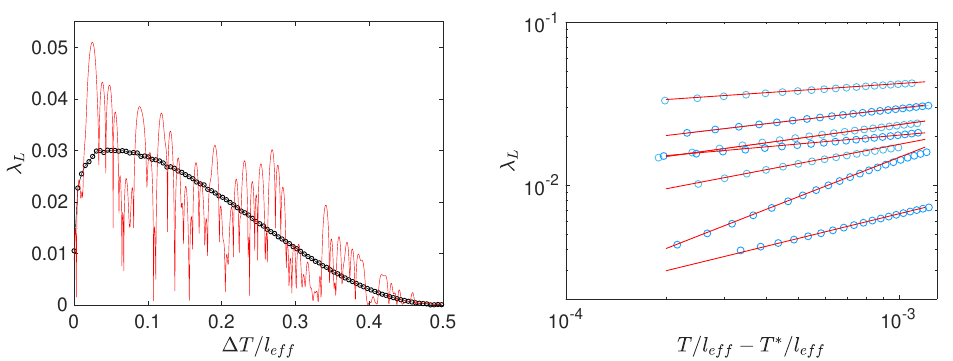
Figure 23: Left: Distribution of Lyapunov exponents obtained from ensemble average (black circles) and in a single random sequence (red solid line) where the random sequence is kept the same for different driving parameters ∆ T / l tocol and parameters are the same as the left plot in Fig. 5, with θ = 0.25. Right: A sample plot of the scaling behavior of Lyapunov exponents near different accidental exceptional points. The locations of accidental exceptional points are denoted by T ∗ / l . Blue dots correspond to the numerical calculations and the red lines are ef f fittings according to y ∝ x α . From top to bottom, the values of α are 0.14, 0.24, 0.28, 0.18, 0.39, 0.8, and 0.5,